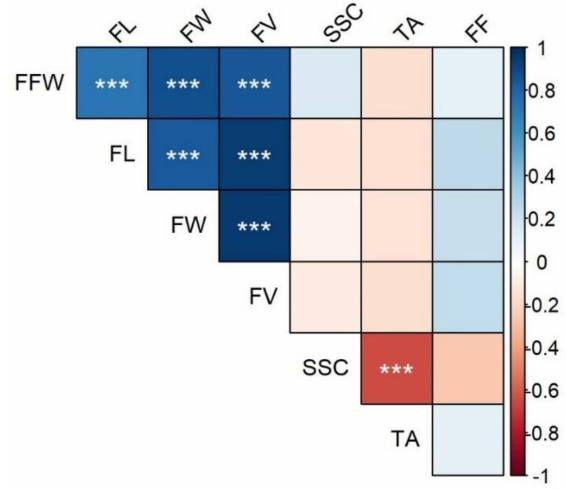
Figure 1. Correlogram (Pearson) of the quantitative variables of the fruits. Pairwise correlations between variables (see Table 2. for the code) are colour-mapped according to the colour scale of the bar on the right-hand side. Asterisks indicate statistically significant correlations (***: p < 0.001). To visualize the relationships among the apricot landraces under investigation, we performed a multivariate cluster analysis using both qualitative and quantitative traits. At a high hierarchical node (k = 2), the top cluster (PAZ-MON) was associated with a yellowish skin colour (13 varieties out of 14), while the bottom (BOC-SCI) mainly with the light orange one (9 out of 14) (Figure 2).